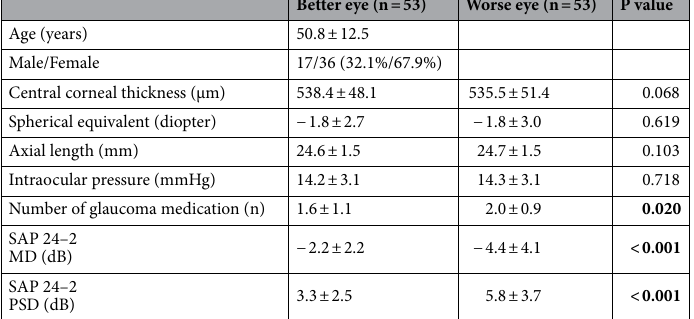
Table 4. Demographics of patients with glaucoma: Intereye comparison. MD, mean deviation; PSD, pattern standard deviation; SAP, standard automated perimetry. *Statistically significant differences between two groups ( P < 0.05) by paired t-test are indicated in